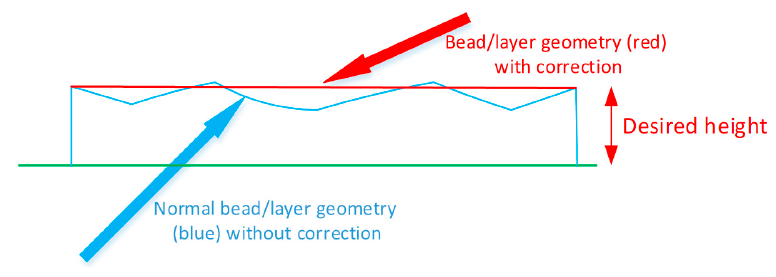
Figure 1. Compensation effect on bead/layer roughness. Appl. Sci. 2019 , 9 , x FOR PEER REVIEW